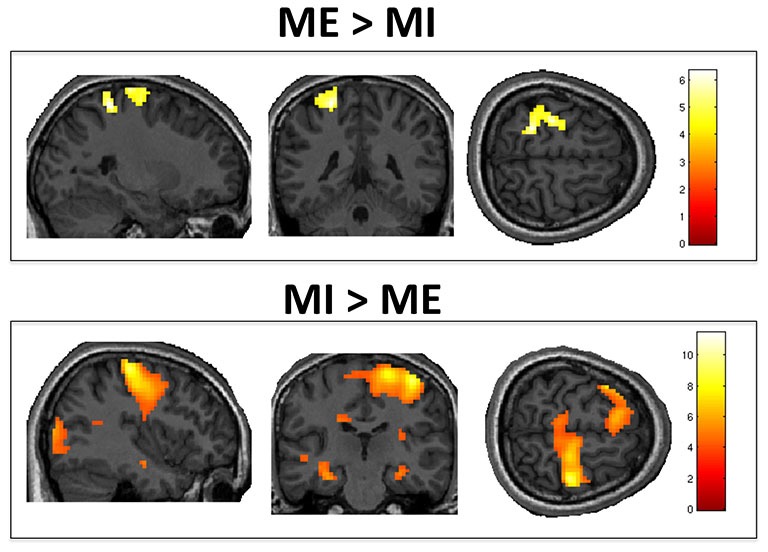
Motor execution vs. motor imagery. Group level analysis showed greater activity in contralateral M1/S1 when motor execution was compared to motor imagery (top panel). Conversely, motor imagery, as compared to motor execution, activated the ipsilateral M1, S1 and left inferior frontal gyrus (bottom panel). Results are thresholded at family wise error (FWE)-corrected p < 0.05 for cluster level activation and overlaid on an anatomical T1-weighted image.